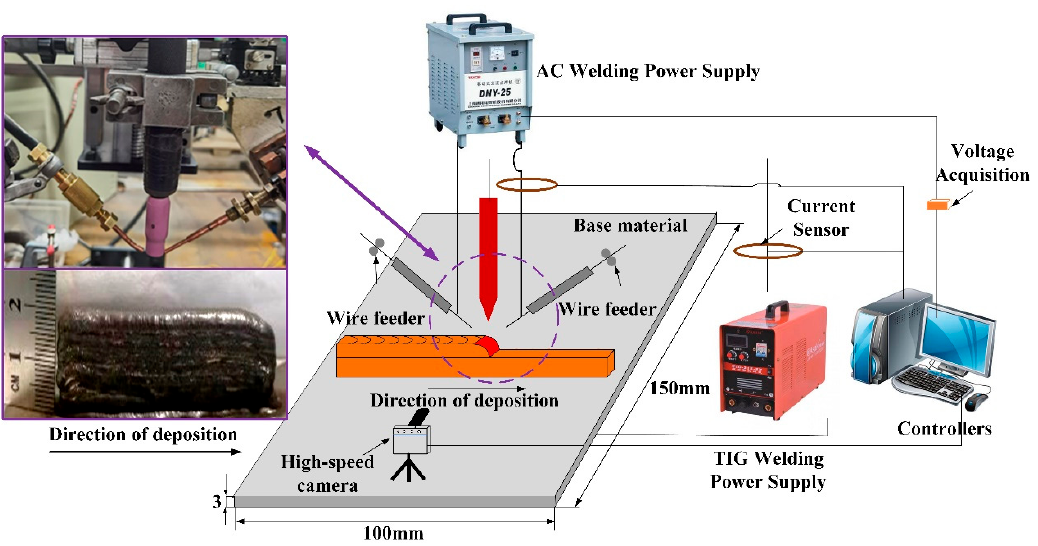
Figure 1. Experimental system of the “TIG + AC” twin-wire cross arc additive manufacturing.